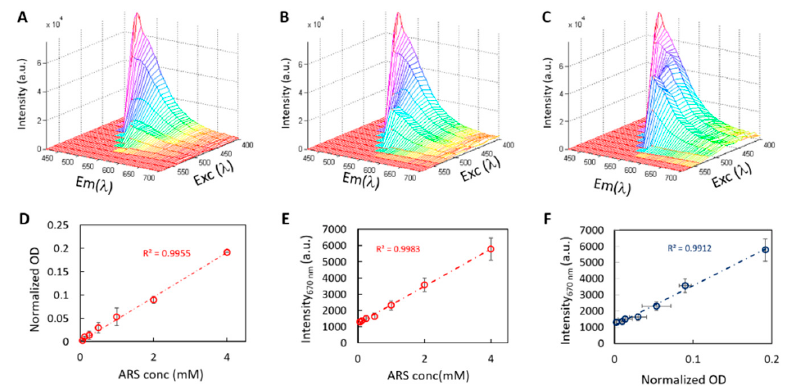
Figure 2. 2D spectra of ARS at increasing concentration: 0.25 mM ( A ), 1 mM ( B ), 4 mM ( C ). OD peak vs. concentration is reported in ( D ) while fluorescence peak at 670 nm (excitation 420 nm) is in ( E ). In ( F ), quantification with the two different methods is plotted. Dashed lines represent the linear fit with the corresponding R 2 value shown.